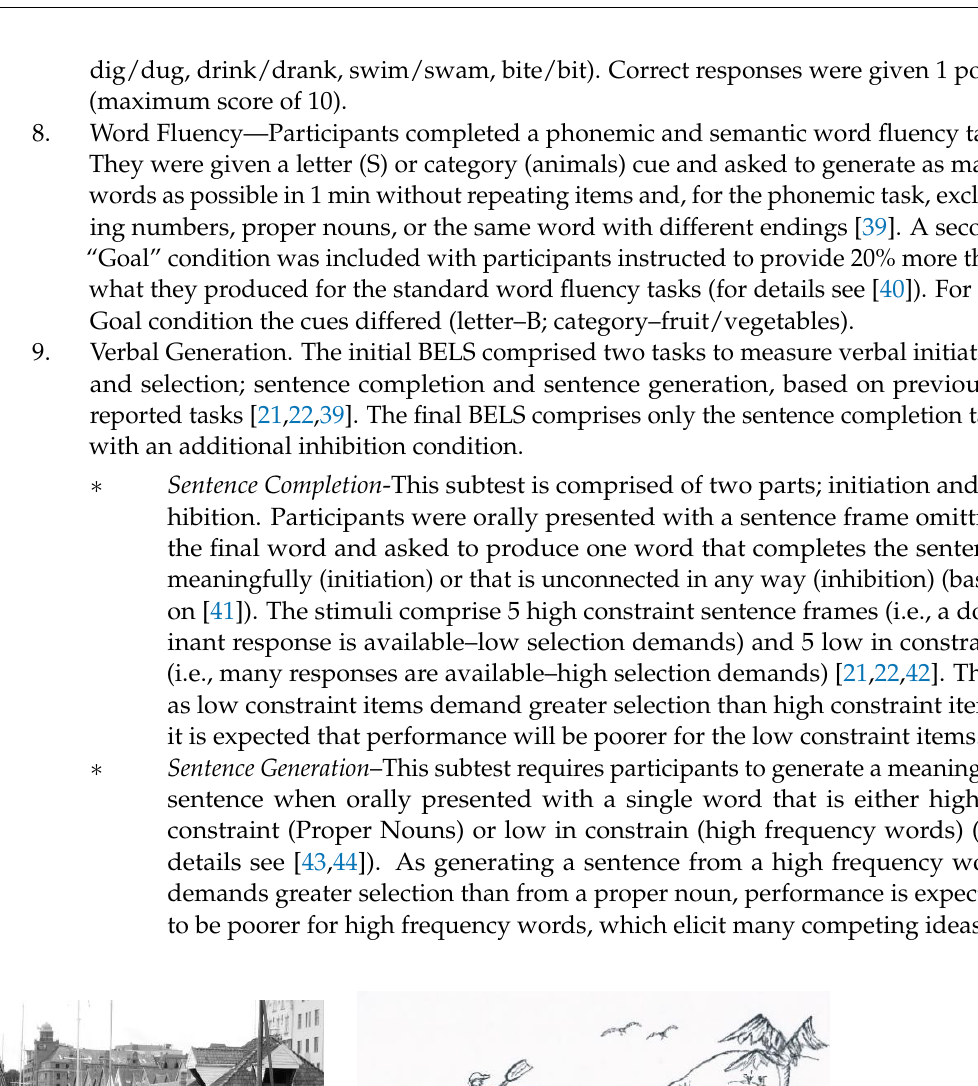
Table 1. Demographics for Participants (Healthy and Stroke groups).